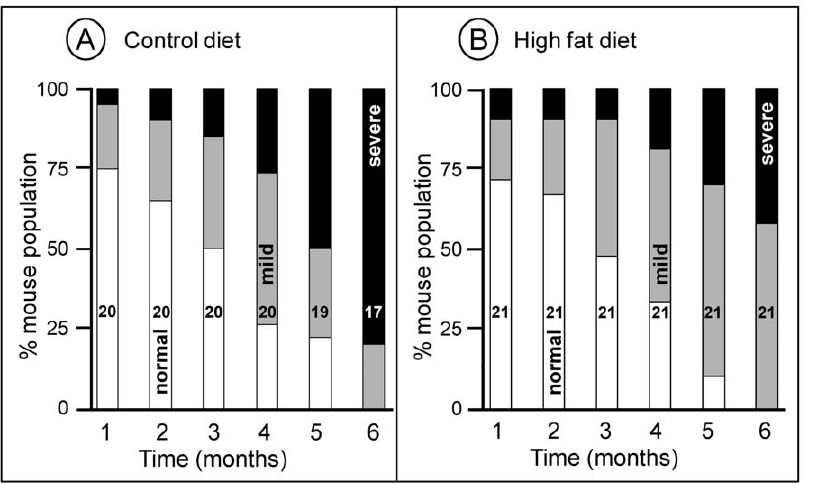
Figure 9. Tail supension test in Harlequin mice fed the control (A) or high fat (B) diet. From 5 months of age, the proportion of less severely affected animals is higher in the HFD group (B). The number (n) of animals is indicated in each bar.